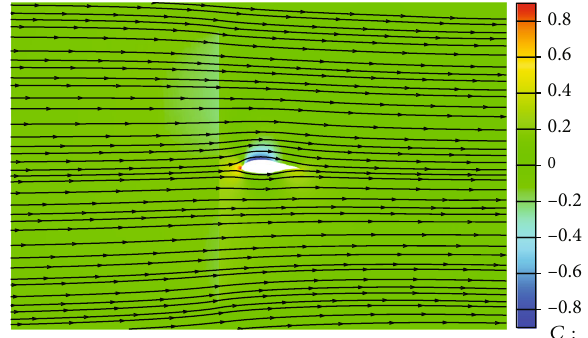
Figure 17: Pressure contours and streamlines in airplane mode with = 0 : 0196 . actuator disk, C T